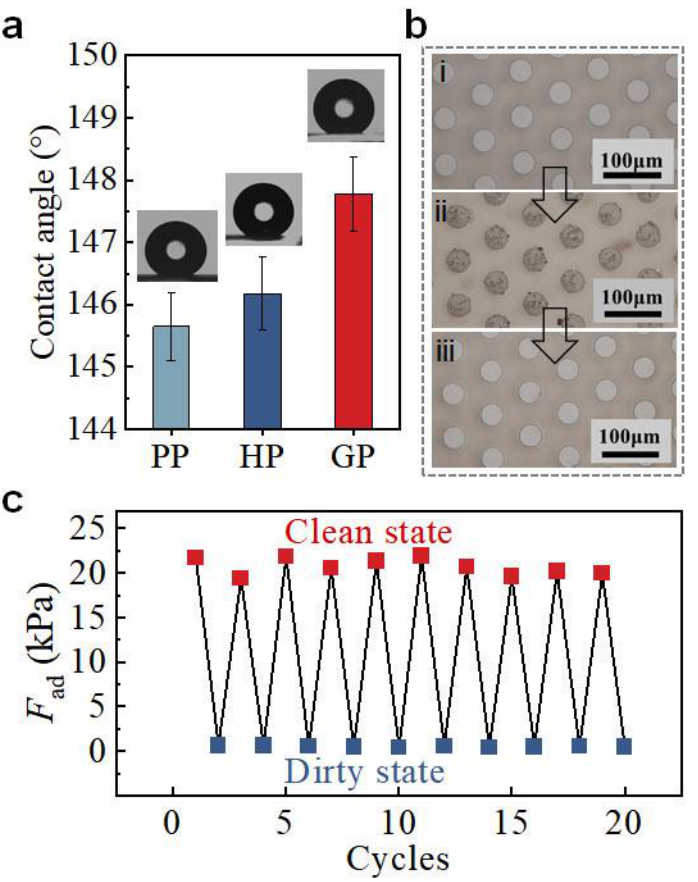
Figure 6. Self-cleaning ability of GP. ( a ) Water contact angles of GP, HP, and PP. ( b ) Photos i to iii represent the initial state of GP, the GP with dust, and the GP after cleaning, respectively. ( c ) F ad of GP at states of i, ii, and iii as indicated in ( b ).